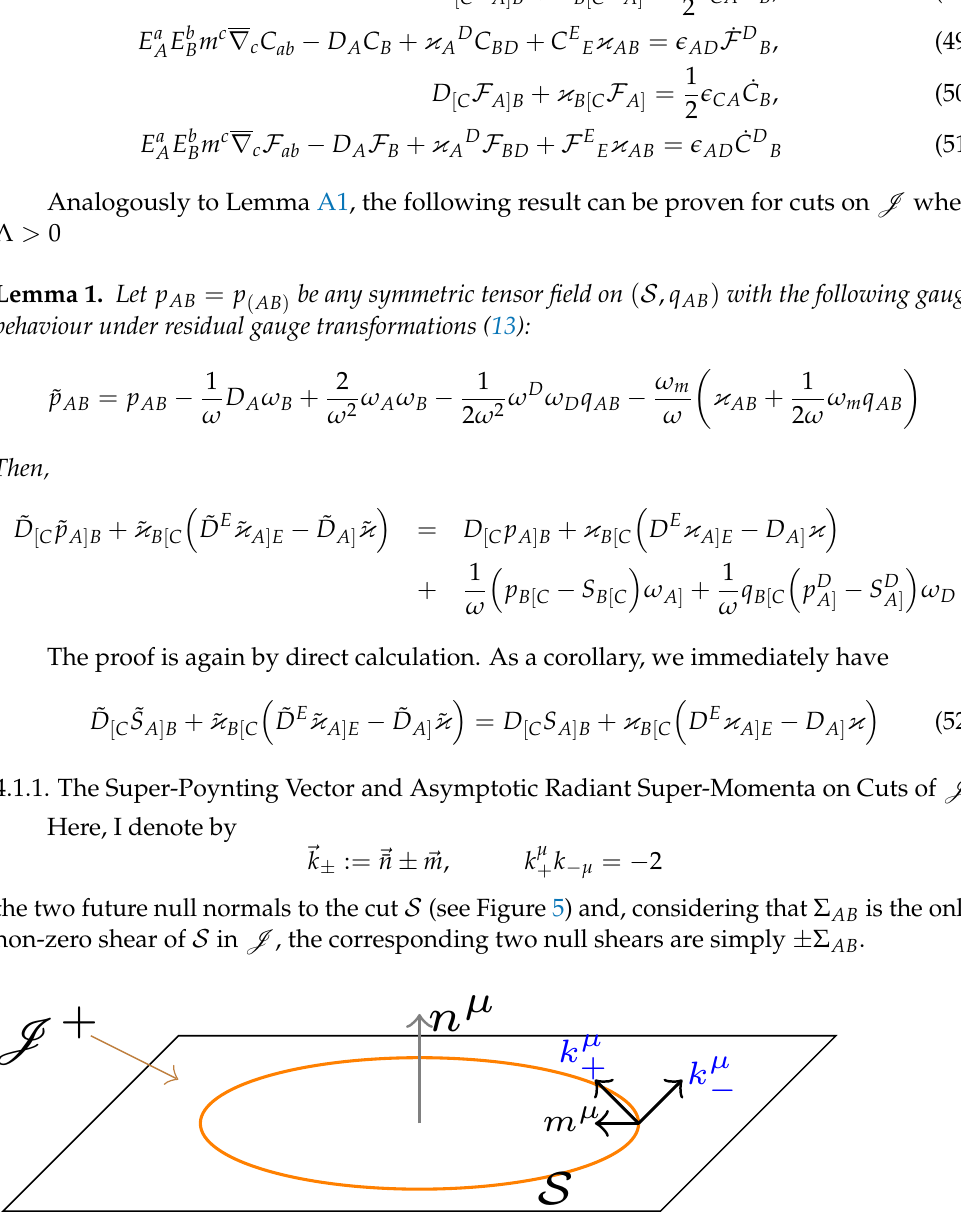
Figure 5. Schematic representation of the two null normals k µ ± = ¯ n µ ± m µ to the cut S at a given point of the